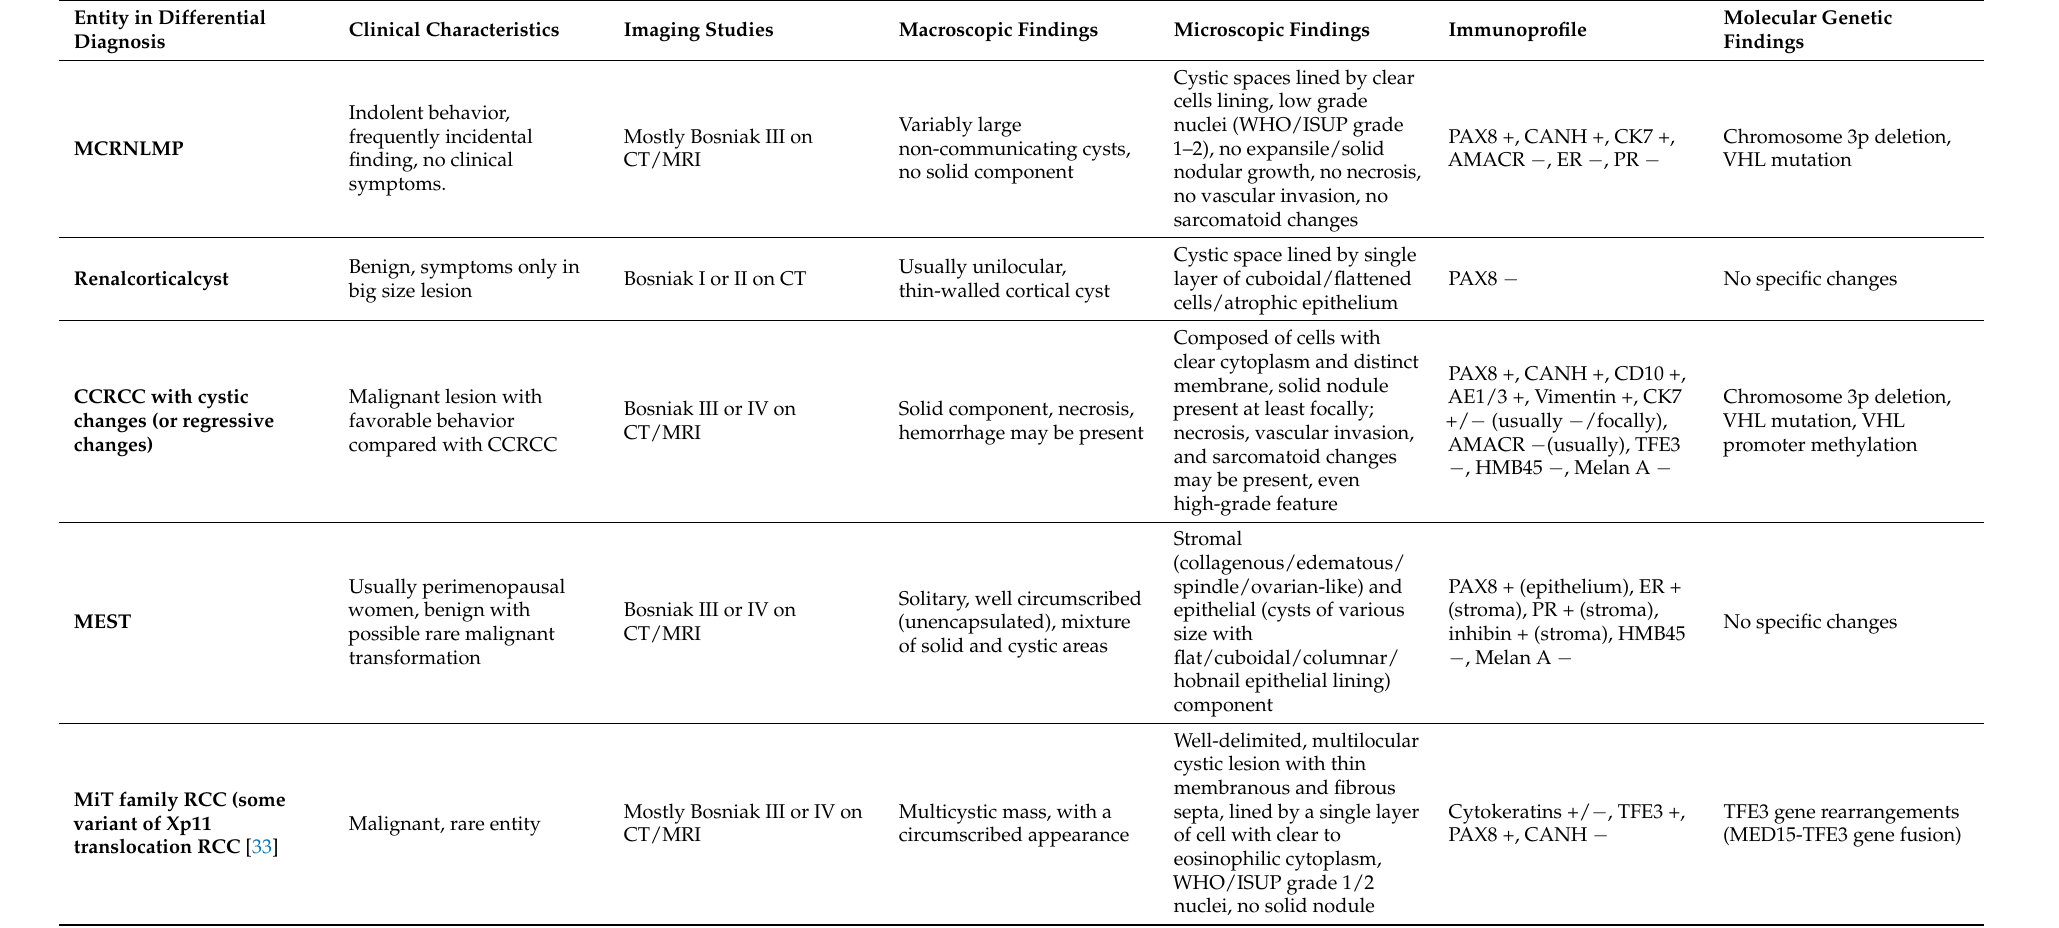
Table 1. Differential